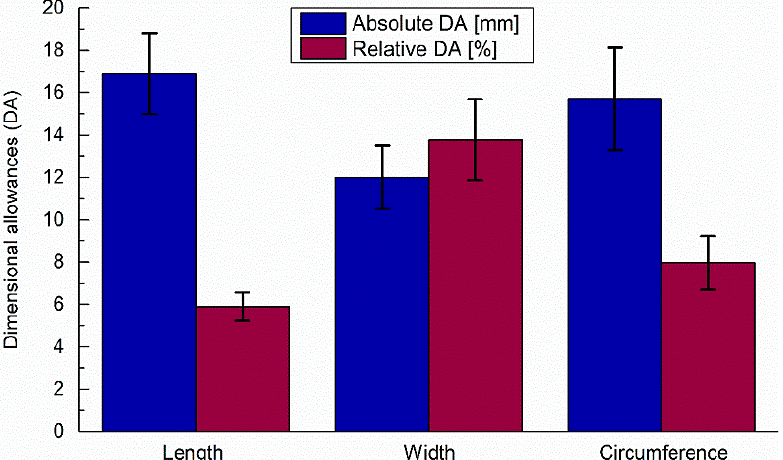
Figure 6. Mean of the absolute and relative dimensional allowances for the three hand anthropometric data between the bare and gloved hand: length, width and circumference with error bars representing the standard deviation of measurements.